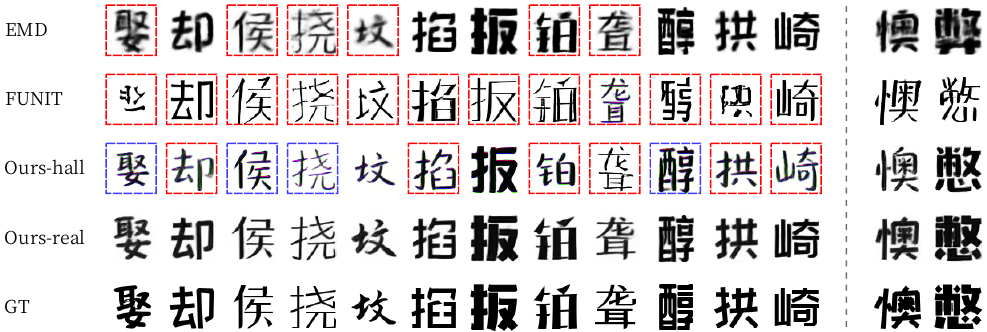
Figure 14. Examples of Chinese unseen font style generation. Red boxes represent ‘bad’ results, blue boxes ‘not bad’ results, and no box ‘good’ results. The last two columns show some failure cases, so we did not mark any box here.